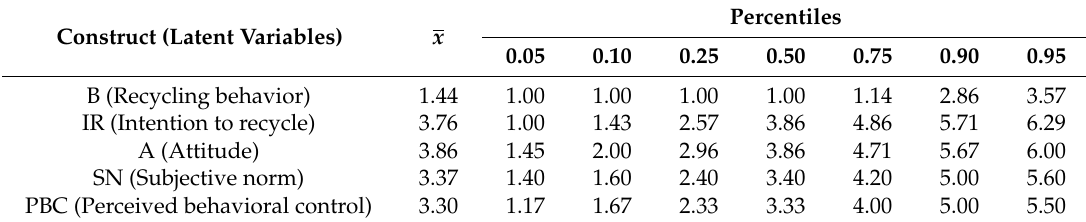
Table 1. Descriptive statistics for the latent variables, mean scores, and percentiles ( n = 2004). Construct (Latent